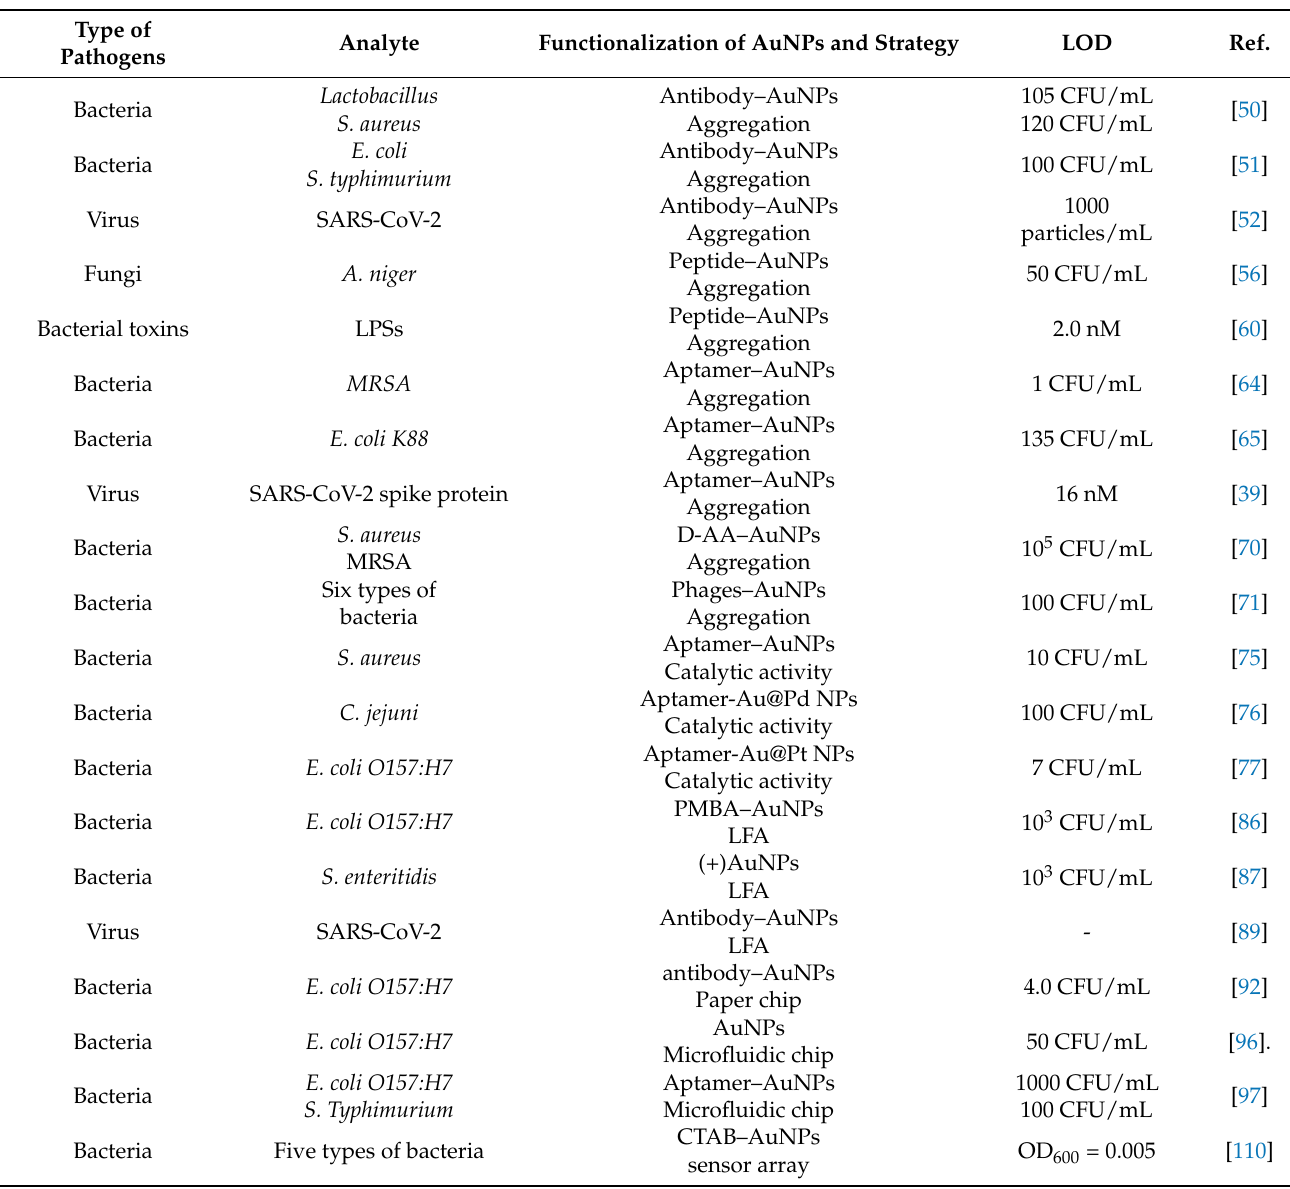
Table 1. Applications of colorimetric sensors based on AuNPs for pathogen